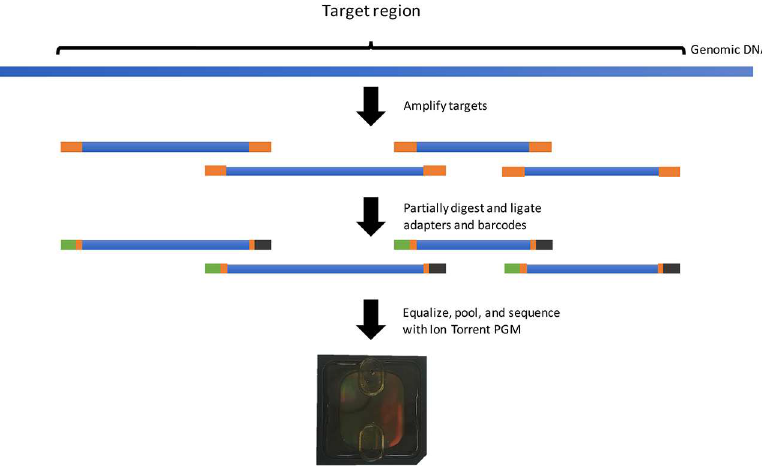
Fig 1. Ampliseq workflow. Target regions are selectedand ampliconsare designed to cover the region. Amplicons are then partiallydigested, and adapters and barcodes are ligated onto amplicons.Samples are then equalized and pooled.Sequencing was completedon an Ion Torrent PGM ™ .